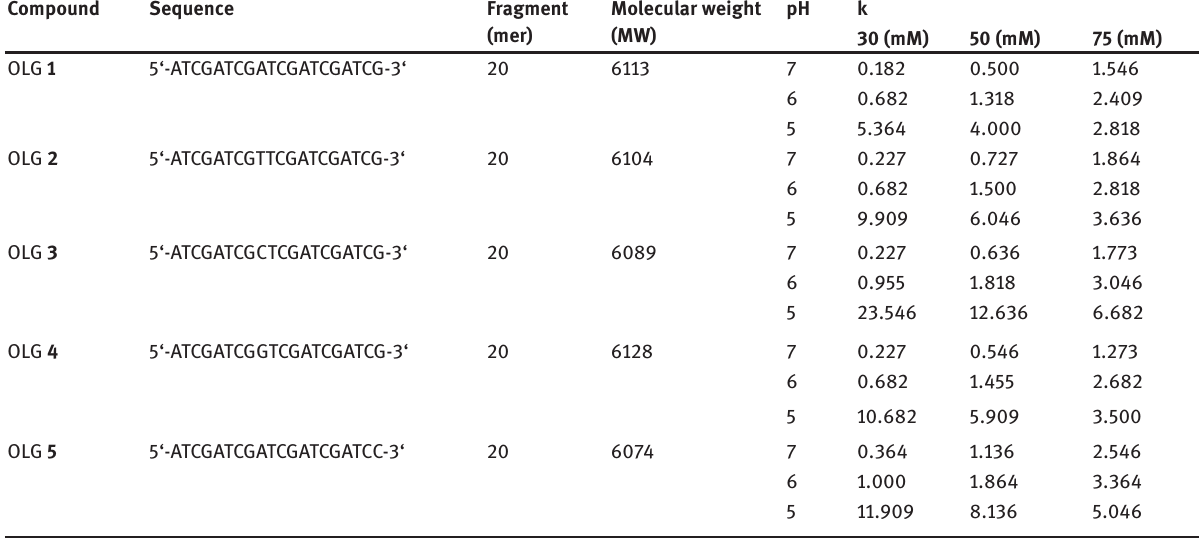
Table 1 : Sequence and retention time of oligonucleotides in different salt concentration and mobile phase buffer pH. Compound